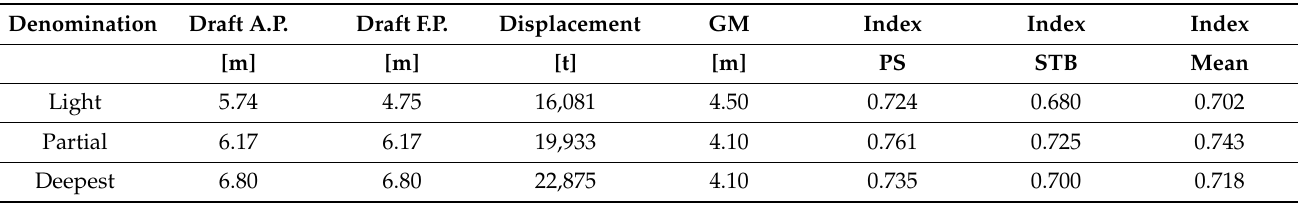
Table 1. Damage stability results for the EMSA 2 RoPax